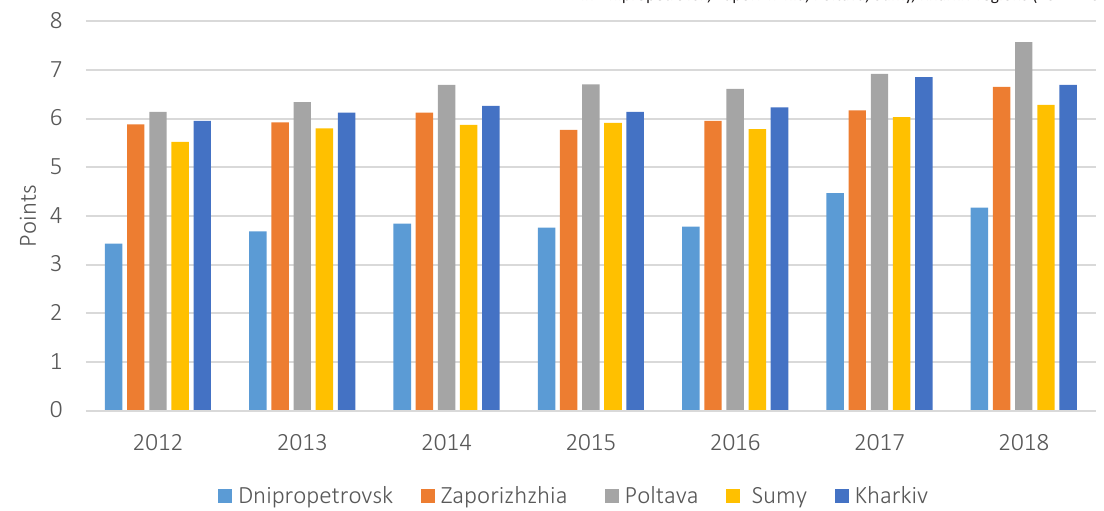
Figure 3. Integral index of level of socio-ecological development of regions